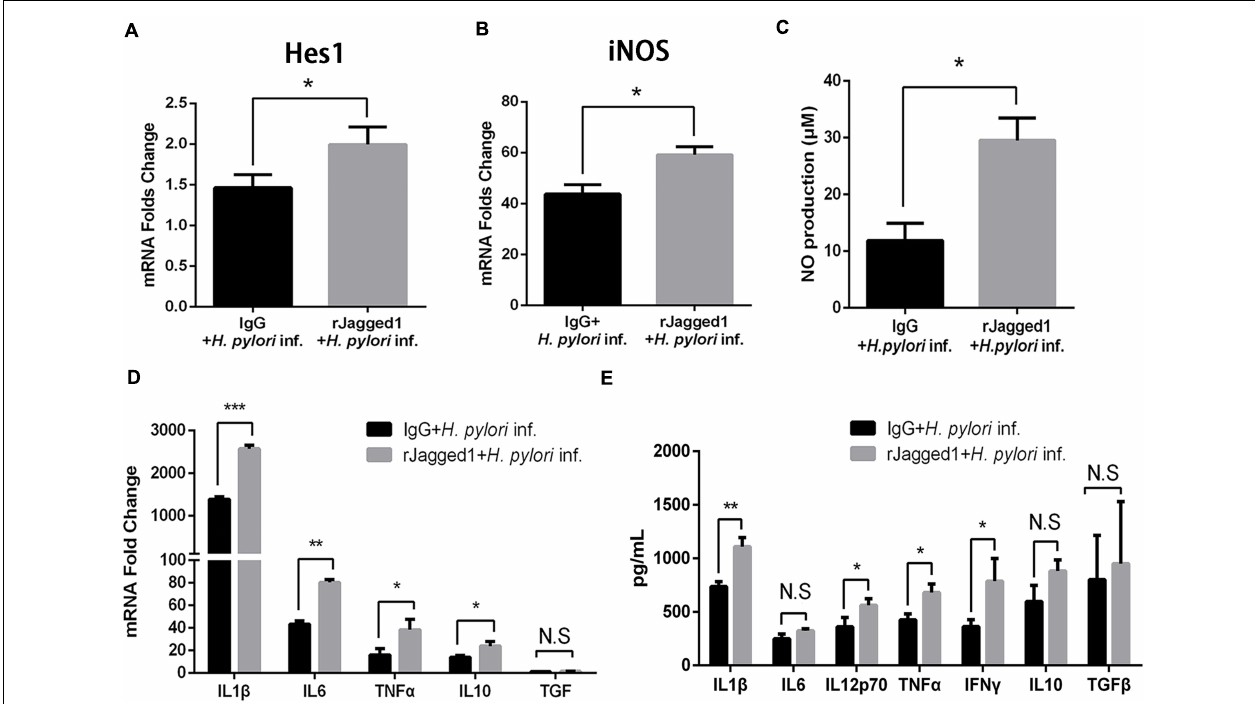
FIGURE 7 | The addition of exogenous rJagged1 enhances the secretion of pro-inflammatory mediators in RAW264.7 cells against H. pylori infection. RAW264.7 cells were pretreated with rJagged1 (10 ng/ml) for 24 h and then co-cultured with H. pylori (MOI = 50) for 12 h. Human IgG was used as negative control for rJagged1, and PBS was used as control for H. pylori infection. Total RNA of each group was extracted. (A) qPCR was performed to examine the mRNA expression of Hes1. (B) qPCR was performed to examine the mRNA expression of iNOS. (C) Griess was performed to test the production of NO in the supernatant. (D) qPCR was performed to examine the mRNA expression of pro-inflammatory cytokines IL1 β , IL6, and TNF α and anti-inflammatory cytokines IL10 and TGF β . (E) ELISA was performed to examine the protein expression levels of pro-inflammatory cytokines IL1 β , IL6, IL12p70, TNF α , and IFN γ and anti-inflammatory cytokines IL10 and TGF β in the supernatant. β -actin was used as reference gene. Data are presented as the mean ± SD of three independent experiments. * p < 0.05, ** p < 0.01 and *** p < 0.001; N.S. represents no significant difference.